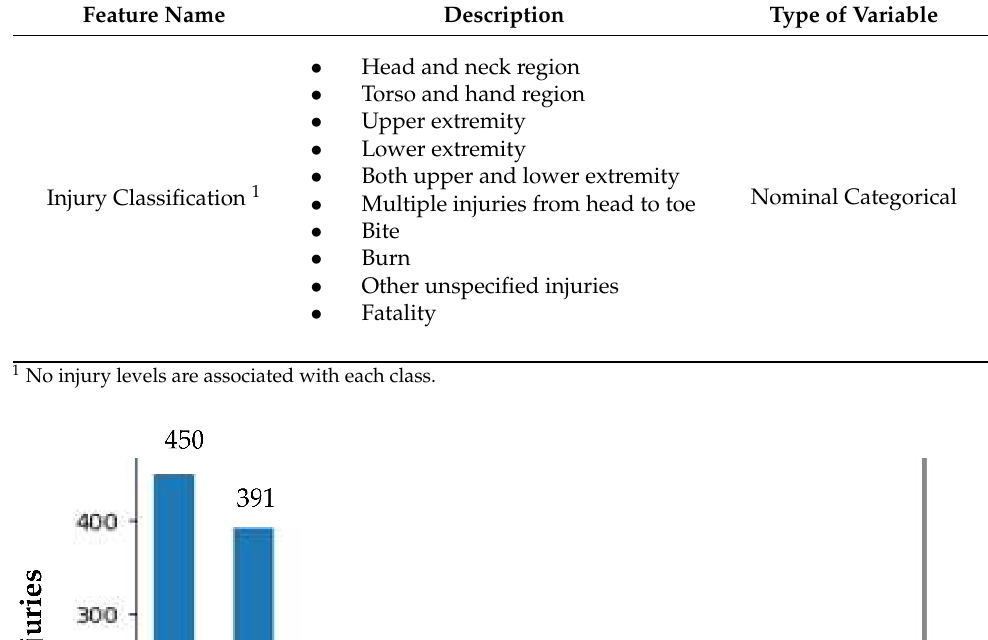
Table 2. Response Variable.